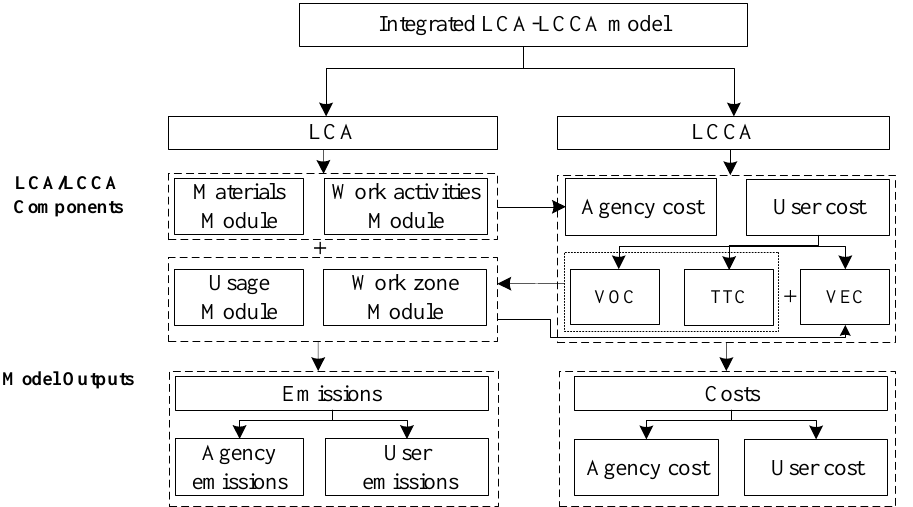
Figure 1. The overall integrated LCA-LCCA framework.